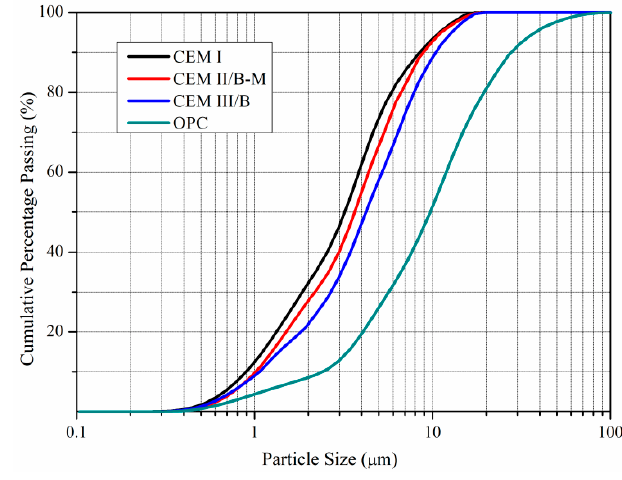
Figure 1. Particle size distributions (PSD) of MCs and OPC.